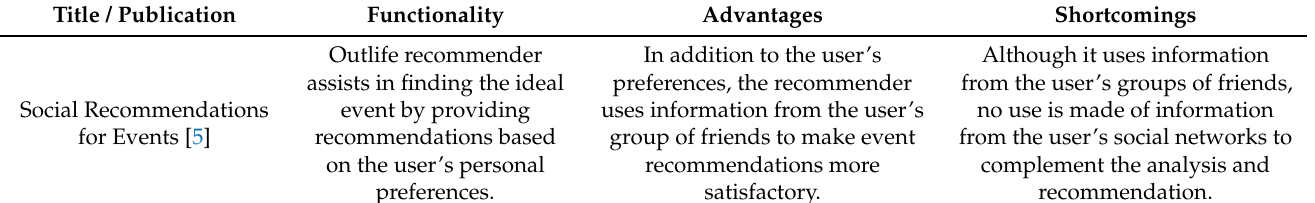
Table 2. Review of similar works: Part